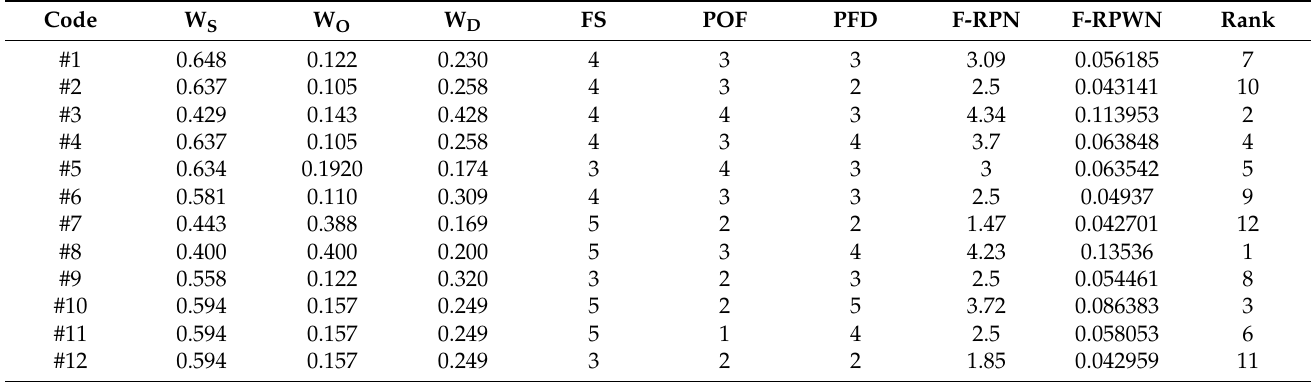
Table 7. Weight, FS, POF, PFD, F-RPN, F-RPWN, and their ranking of failure mode.